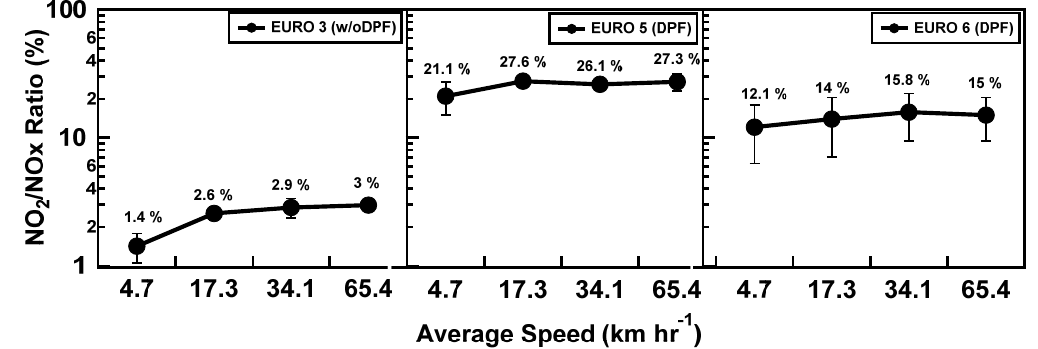
Figure 5. Observed trends in the variation of NO 2 / NOx ratio and standard deviation concerning emissions from diesel vehicles as per different emission-regulation standards for different diesel-vehicle speeds.